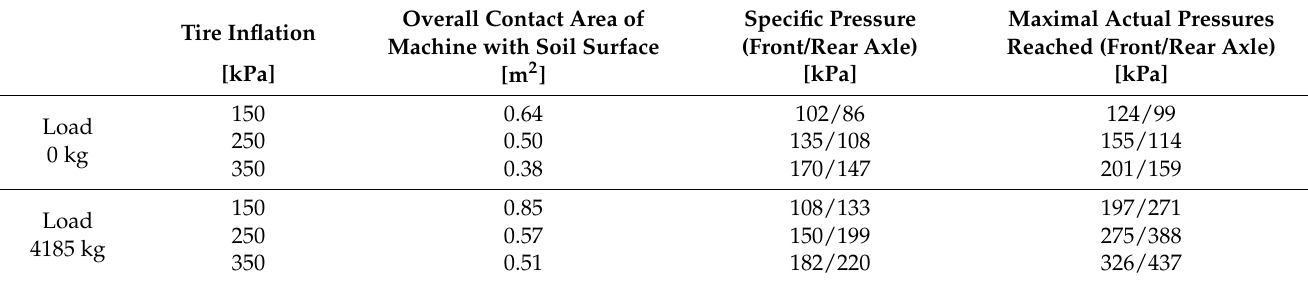
Table 1. Specific pressures of a wheeled forwarder on the soil surface and actual pressures at a soil profile depth of 15 cm. Tire